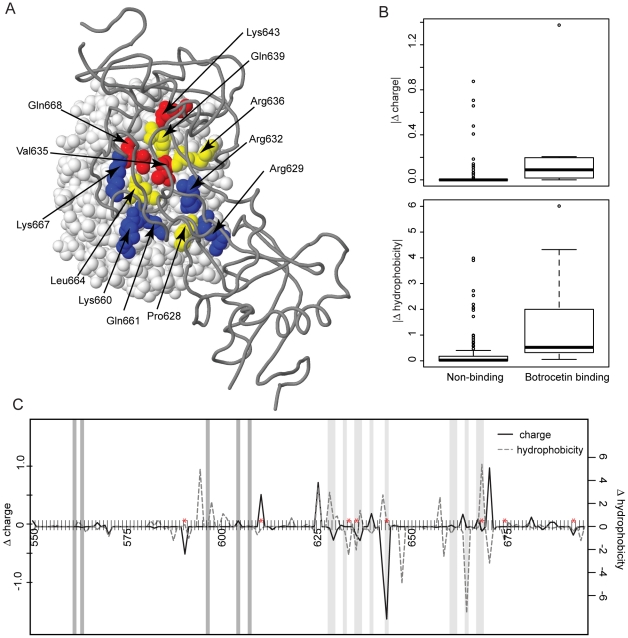
Structure and functional analyses of the vWF-A1 domain.A. The structure of the mouse vWF A1 domain complexed with botrocetin (Protein Data Bank file 1U0O [47]; image realized using Geneious v.5.0.3 [78]). The two chains of botrocetin are shown as a dark grey trace model. The vWF A1 domain is shown as a light grey spacefill model, with residues that are involved in botrocetin binding shown in color (yellow, red, or blue). Amino acid residues identified as being under positive selection in the lineage of venom-resistant opossums (Didelphini) are shown in red (P≥0.95) or yellow (0.5<P<0.95). Residues that are colored blue are involved in botrocetin binding but are not inferred to be under positive selection in opossums. B. Box plots of the absolute value of change in amino acid charge (top) and hydrophobicity (bottom) between venom-resistant and non-resistant taxa for sites of the vWF-A1 domain that bind botrocetin and those that do not. C. A site-by-site sliding window analysis along the vWF-A1 domain showing the average change in charge (solid line) and hydrophobicity (dashed line) between resistant and non-resistant taxa. Botrocetin-binding sites are indicated with pale grey bars, sites that bind platelet glycoprotein Ibα are dark grey, and sites that are under positive selection in venom-resistant opossums are indicated with red asterisks.